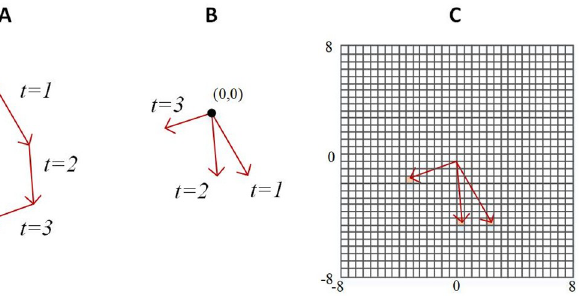
Fig 3. Demonstration of the steps for binning the player movement vectors for the calculation of the collective entropy H . Starting with the series of movement vectors for each player for each time step within the window (in group this example 3), depicted in (A), the movement vectors are transformed so that each vector starts at the origin (0,0), depicted in (B). These transformed vectors are designated to a 2-dimensional bin, depicted in (C), allowing for the calculation of P(x ij ) for all bins.